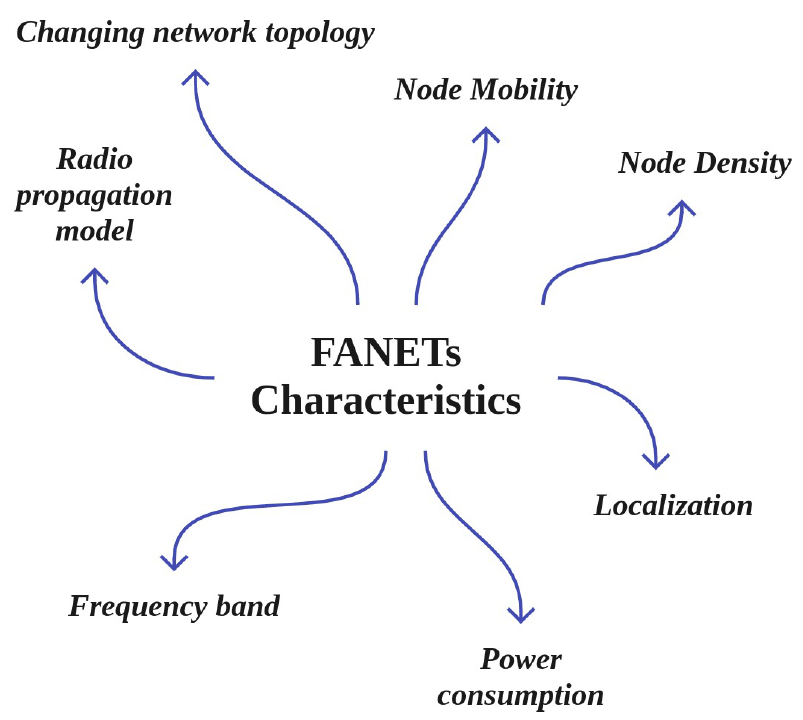
Figure 3. FANET characteristics, including localization, power consumption, frequency band, radio propagation model, changing network topology, node mobility, and node